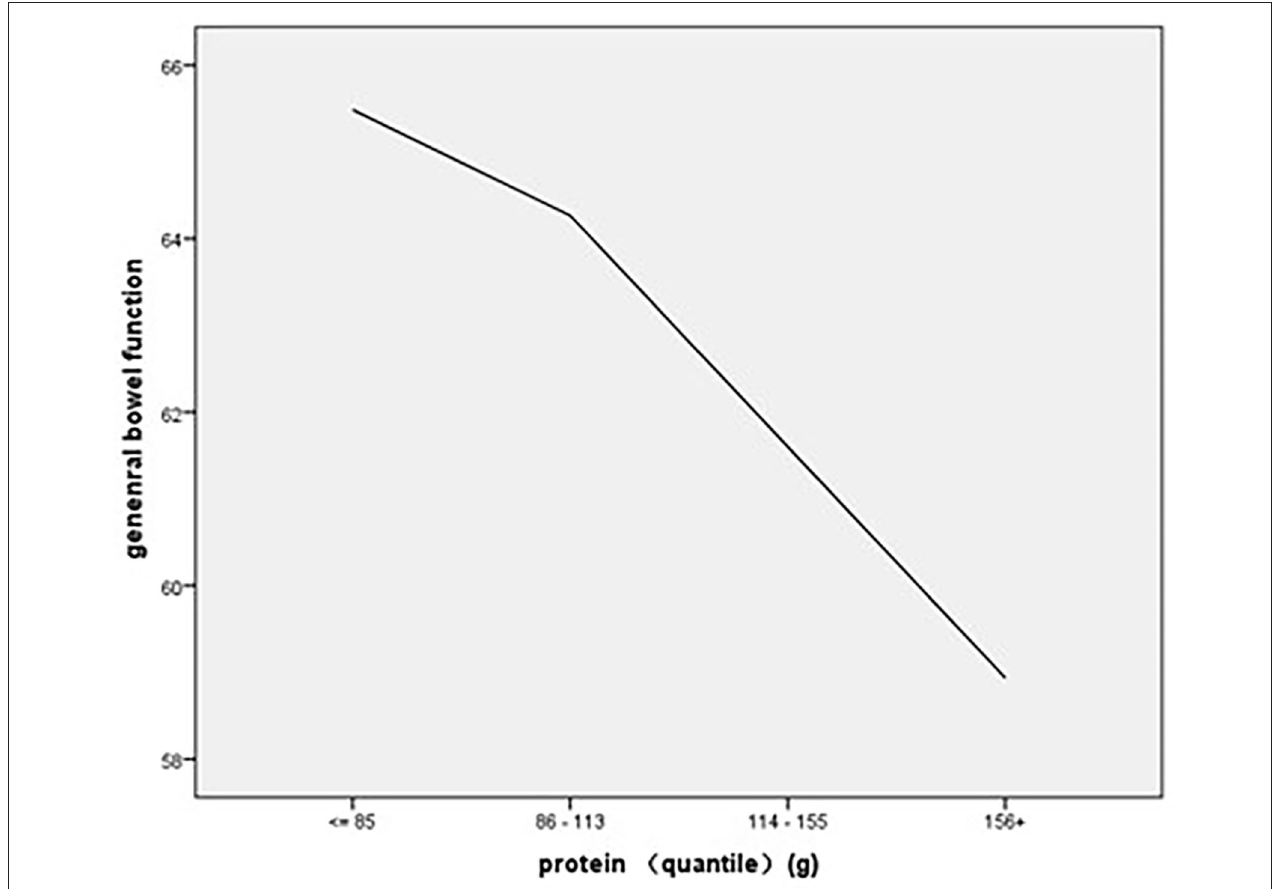
FIGURE 2 | The association of stratified quintiles of consumption of protein with general bowel function.